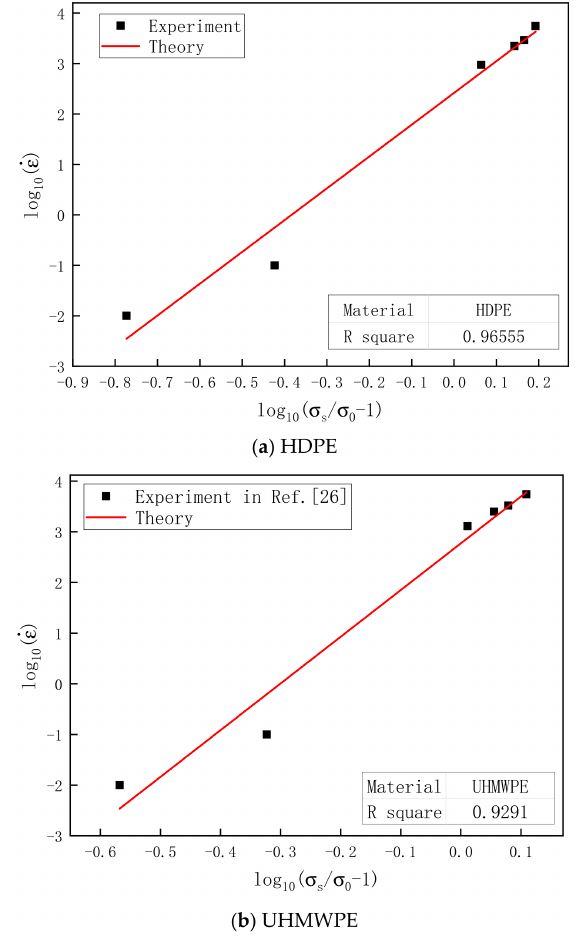
Figure 8. Relationship between the yield stress and strain rate for ( a ) HDPE and ( b ) UHMWPE. The stress–strain curves of HDPE (at an average strain rate of 935 s − 1 ) and UHMWPE (at an average strain rate of 1300 s − 1 ) at different temperatures are displayed in Figure 9a,b, respectively. According to the test results, HDPE and UHMWPE still showed strong temperature-softening effect at high strain rates.